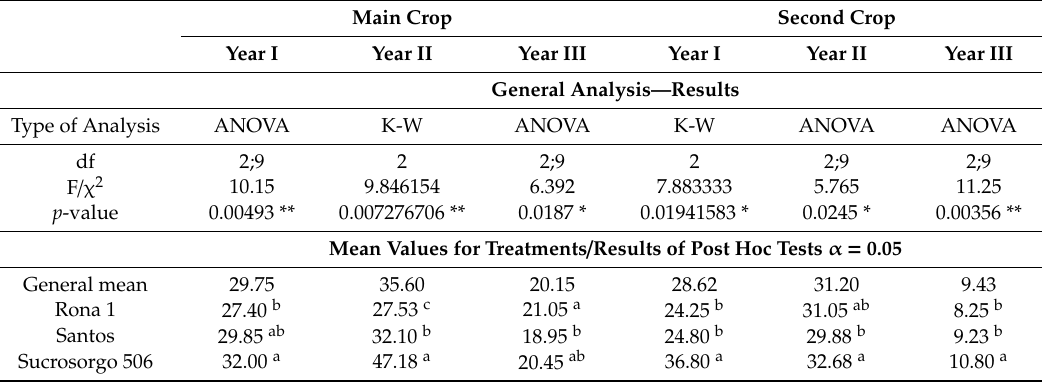
Table 2. Statistical analysis of sorghum straw dry matter yield (Mg · ha − 1